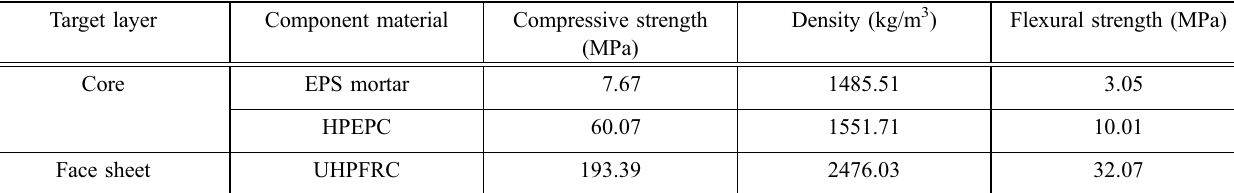
Fig. 4 Test set-ups for a flatwise compression test, b edgewise compression test, and c four-point bending test. Table 5 Mechanical properties of component materials.